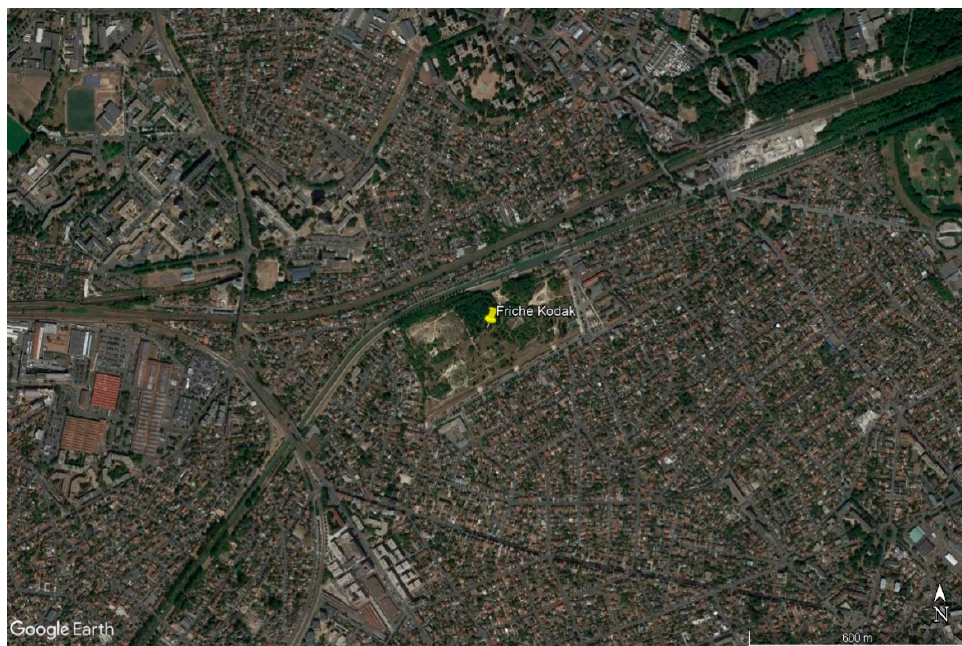
Figure 12. Modelled average and maximum air temperatures at La friche Kodak on 23 July 2019. The park is the roughly rectangular cool spot at the centre of each image.